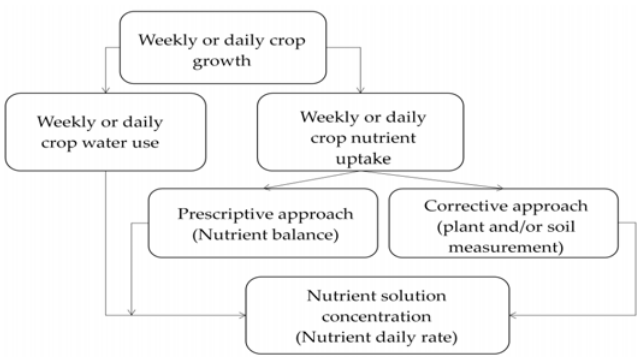
Figure 3. Conceptual framework for the calculation of the fertilizer supply rate in fertigated crops, following different theoretical approaches.